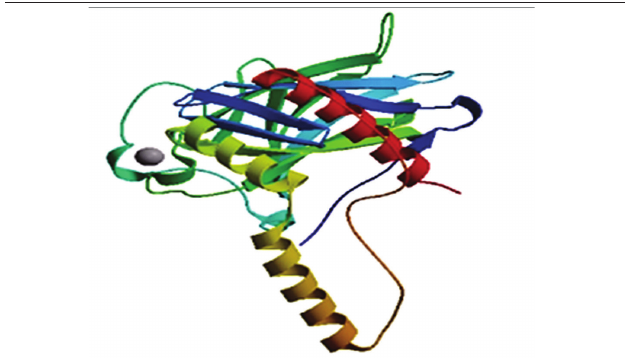
figurE 8 − Tumor suppressor TP53 [ Homo sapiens